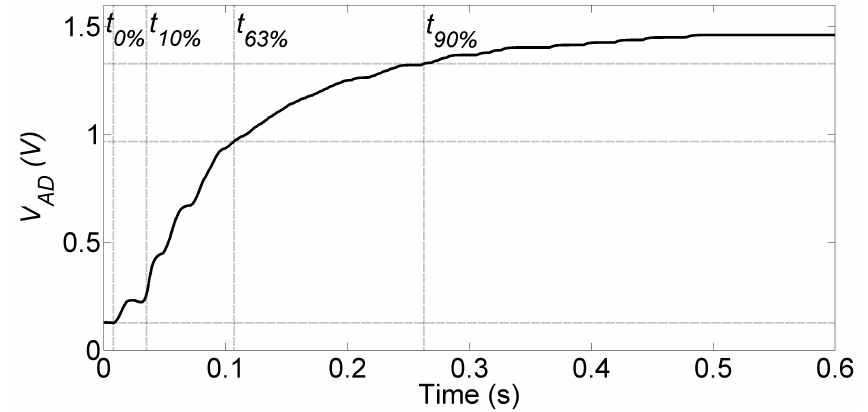
Figure 11. Step response of the subsystem sensor analog front-end. Lines indicate the V AD crossing the 0%, 10%, 63%, and 90% values of its asymptotic